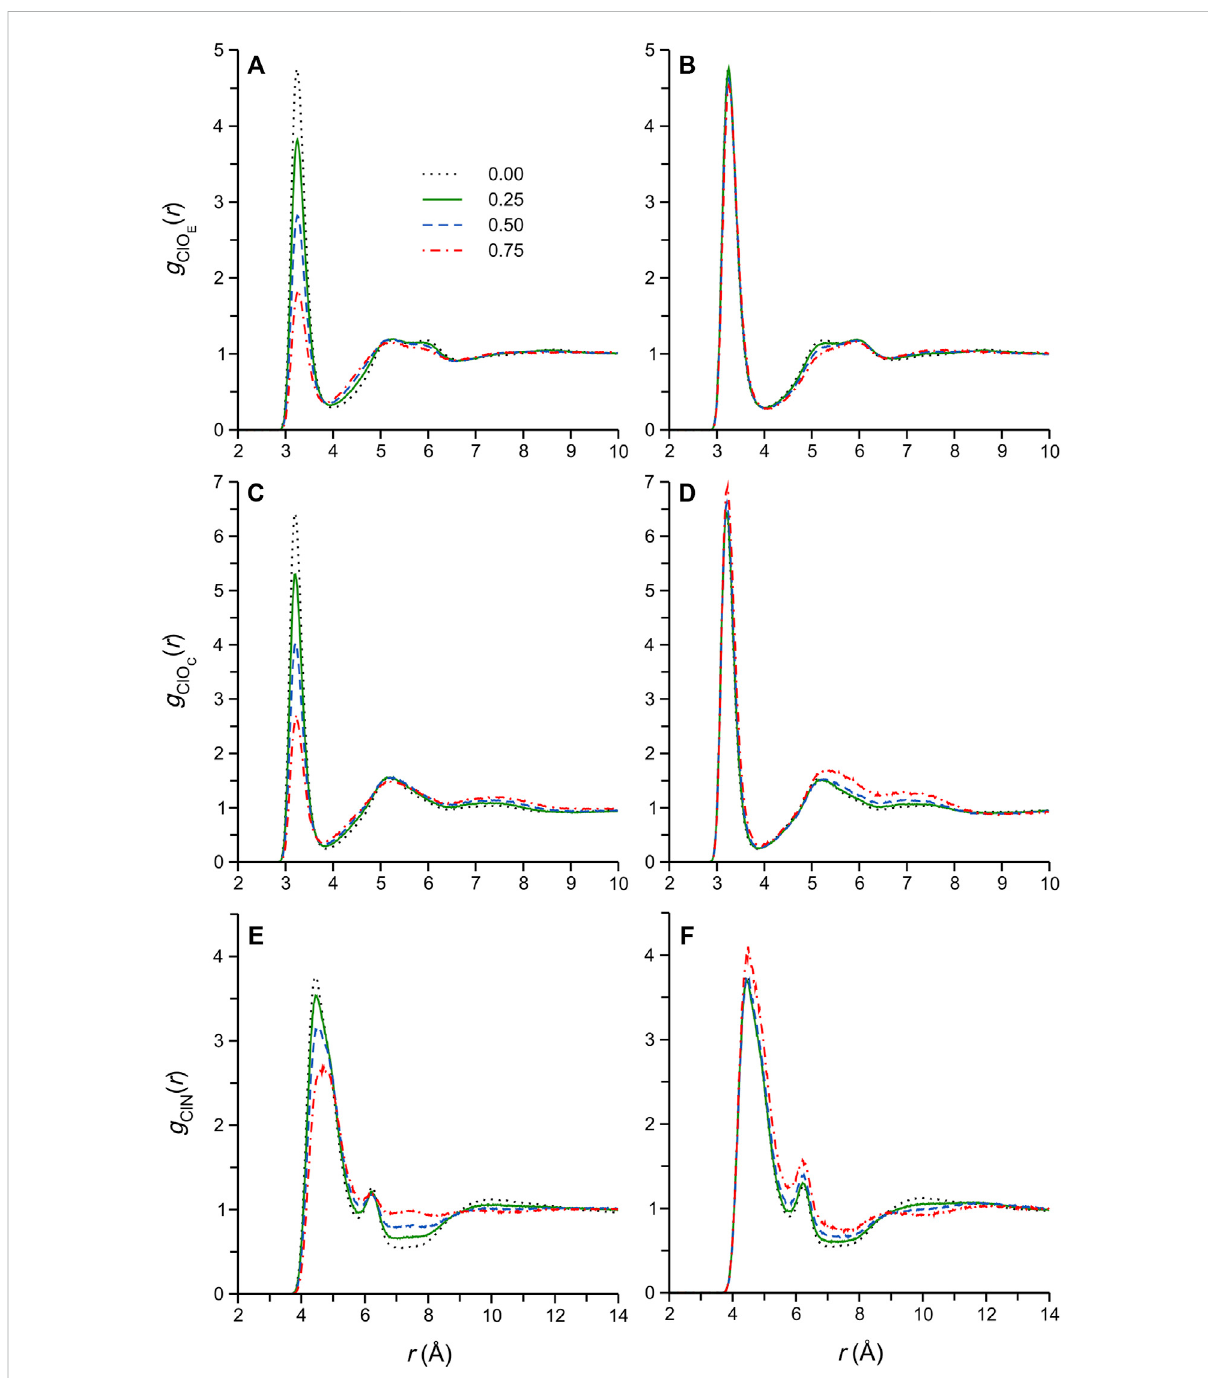
FIGURE 3 Radial distribution functions, g Cl X ( r ), computed for Cl − - X atom pairs for selected DES/water (A,C,E) and DES/methanol (B,D,F) systems, where X = O E (EG oxygen atoms), O C (cation oxygen atom), or N (cation N atom). The legend in (A) pertains to all other panels as well, and shows the mole fraction of the cosolvent in the corresponding simulated